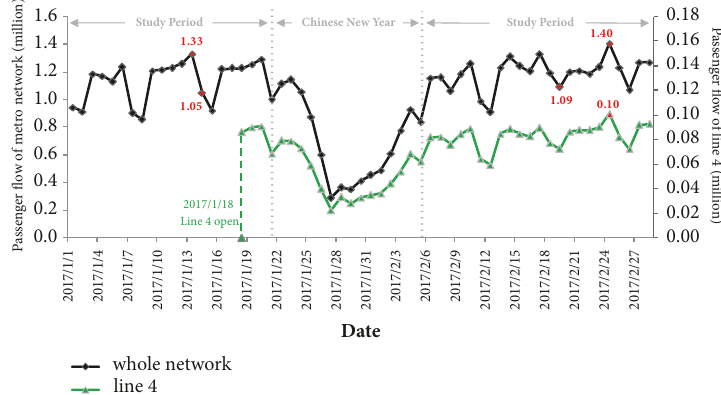
Figure 2: Daily metro passenger flow before and after Line 4 opening.